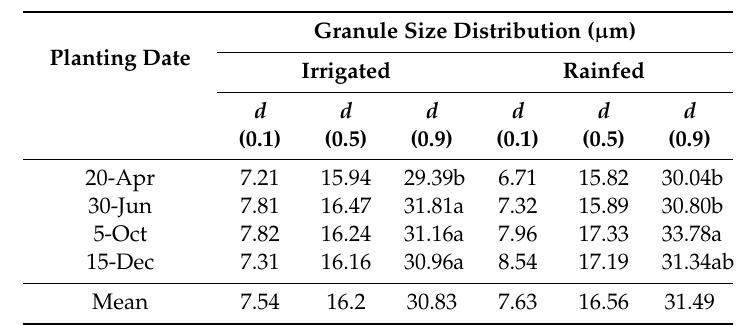
Table 4. Means for granule size distribution of starch isolated from storage roots of cassava cv. Rayong 9 under irrigated and rainfed condition at harvest (12 MAP).